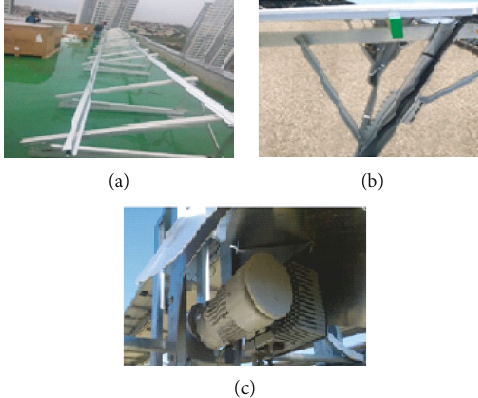
Figure 5: (a) PV panels for the fi xed-angle, (b) manually adjustable-angle, and (c) solar tracking SPPs.